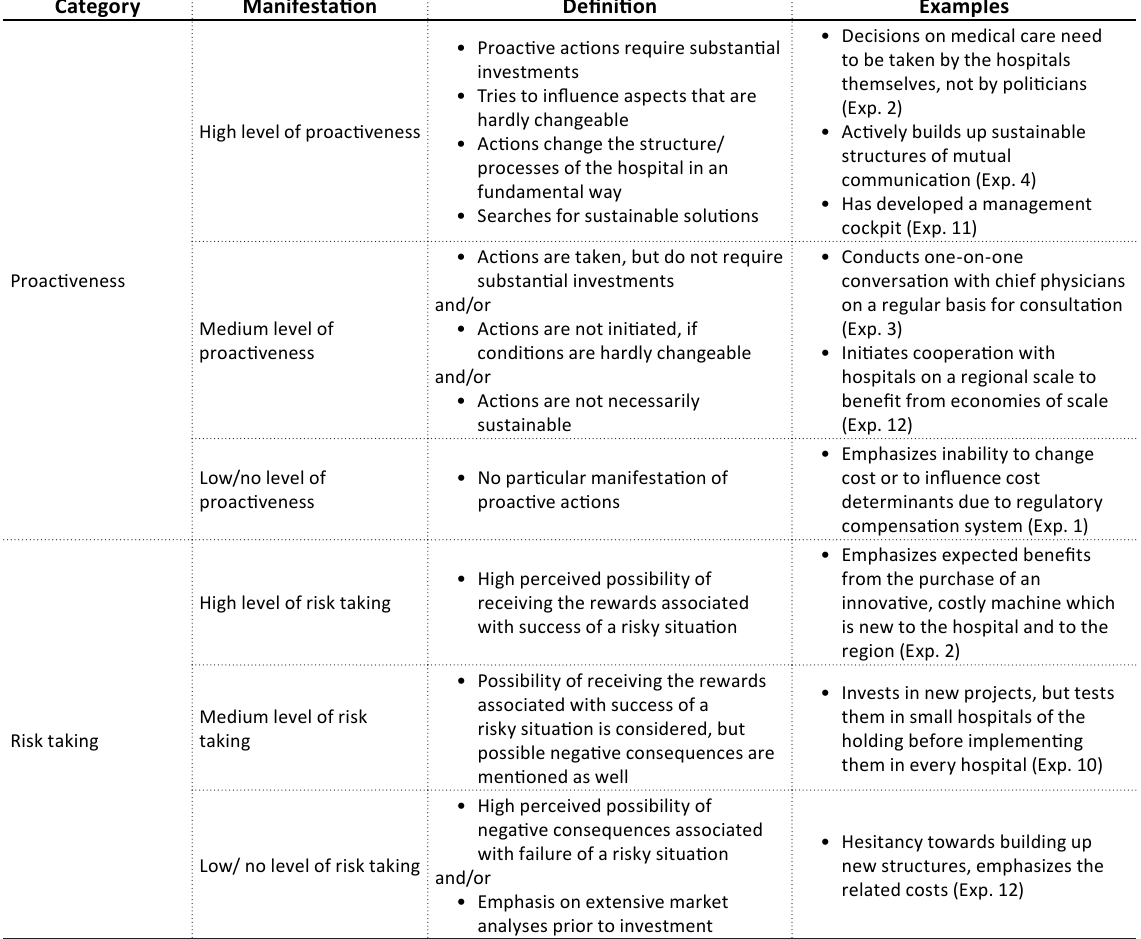
Table A4. Managerial entrepreneurial orientation and hospital strategies Hospital